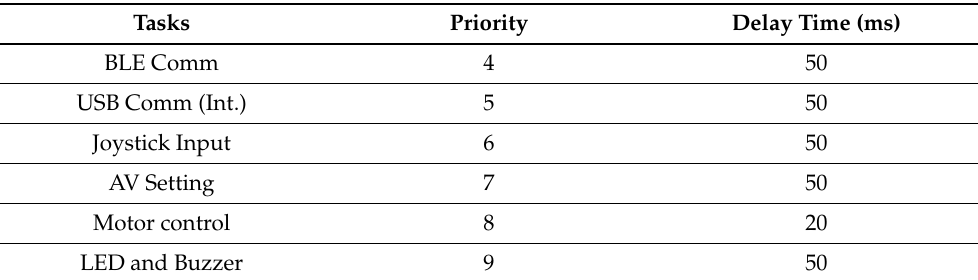
Table 3. Task priorities and delay